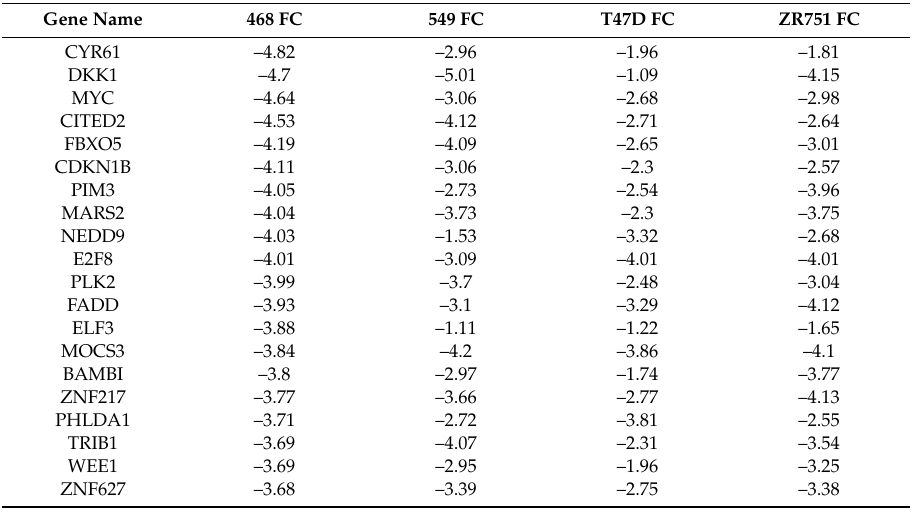
Table 2. Genes that are altered greater than 2-fold in MDA-MB-468, BT549, T47D and ZR751 cells were ranked by the fold change in MDA-MB-468 and the top 20 genes are